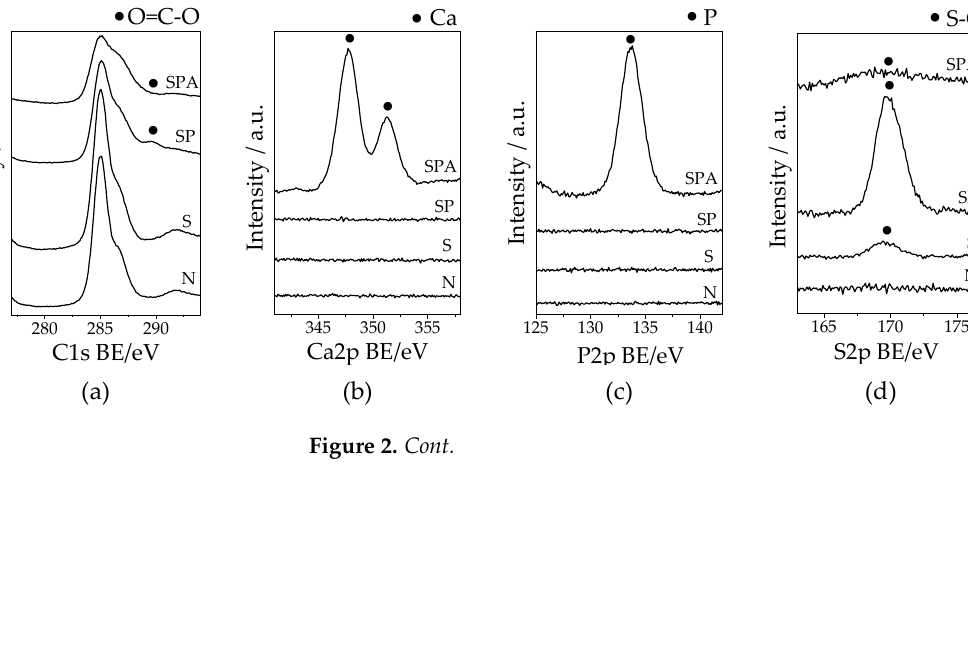
Figure 2. XPS narrow spectra around binding energy of C1s, Ca2p, P2p, and S2p on the surfaces of ( a – d ) pure PEEK and ( e – h ) 50C-PEEK .